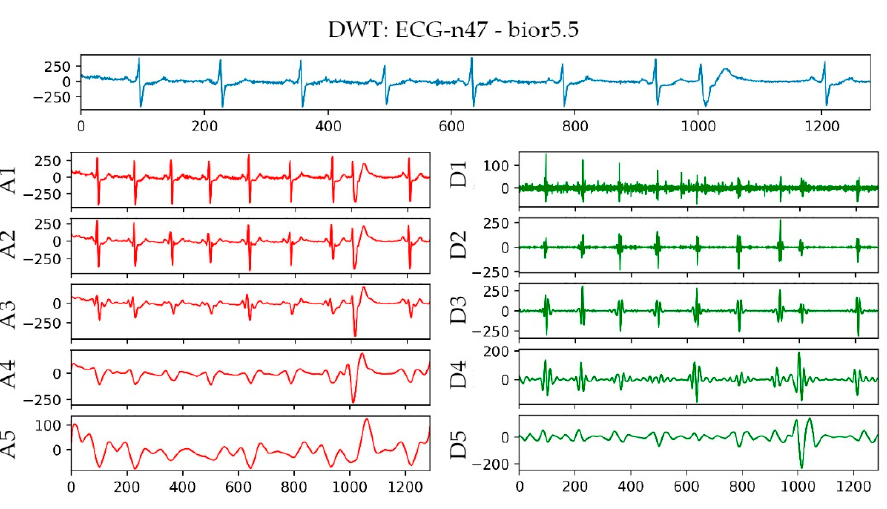
Figure 5. Wavelet transform result graph of No. n47 ECG.